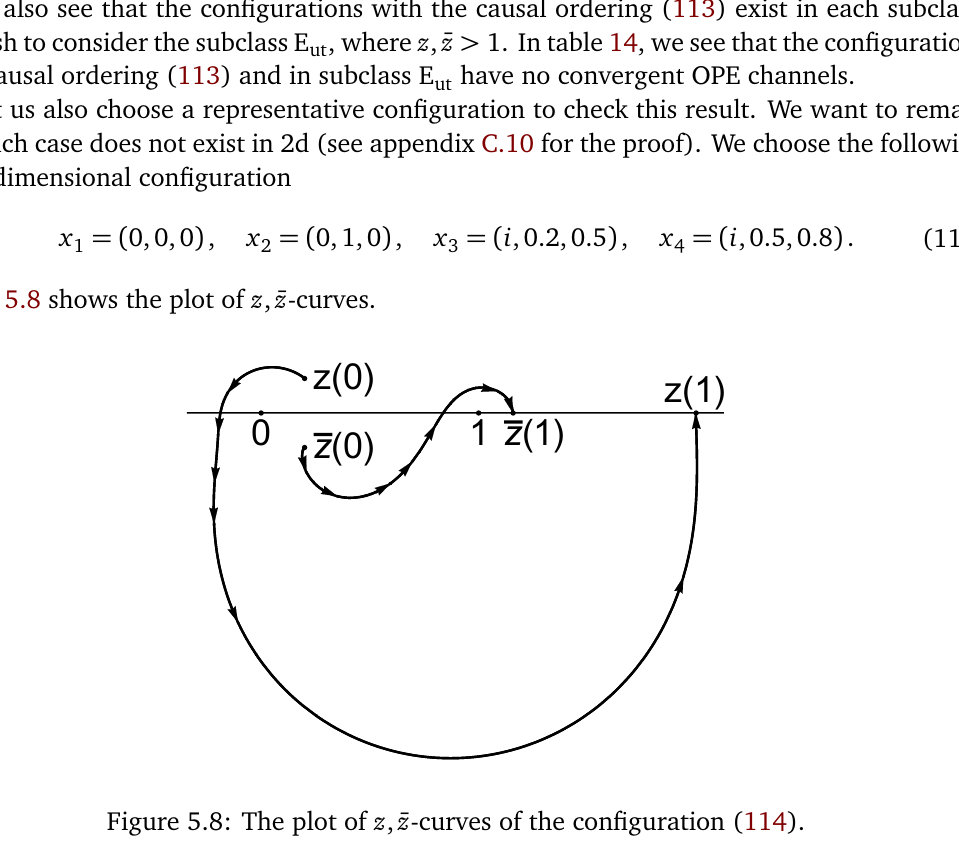
Figure 5.8: The plot of z , ¯ z -curves of the configuration